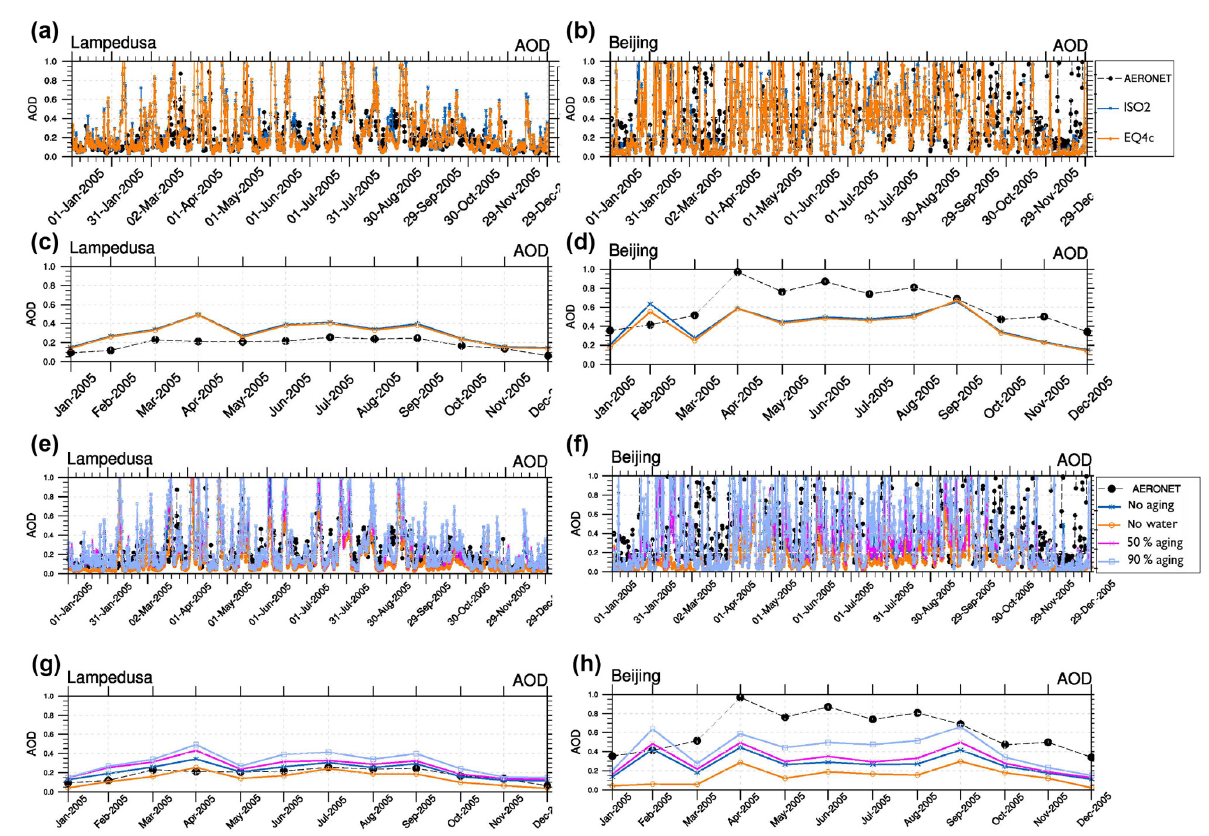
Figure 13. EMAC AOD results versus AERONET observations at Lampedusa and Beijing (shown in Fig. 2) for the year 2005. The first and third rows show 5-hourly means; the second and third rows show monthly means. Panels (a) and (b) show EQSAM4clim (EQ4c) and ISORROPIA II (ISO2). Panels (g) and (h) show sensitivity of EMAC AOD to different water assumptions considering different EMAC setups: no aging (blue stars), no water without aerosol water (orange circles), 50% aging (pink crosses), and 90% aging (light blue squares); see Tables 4 and 2 (Sect. 4.2). The sensitivity is based on ISORROPIA